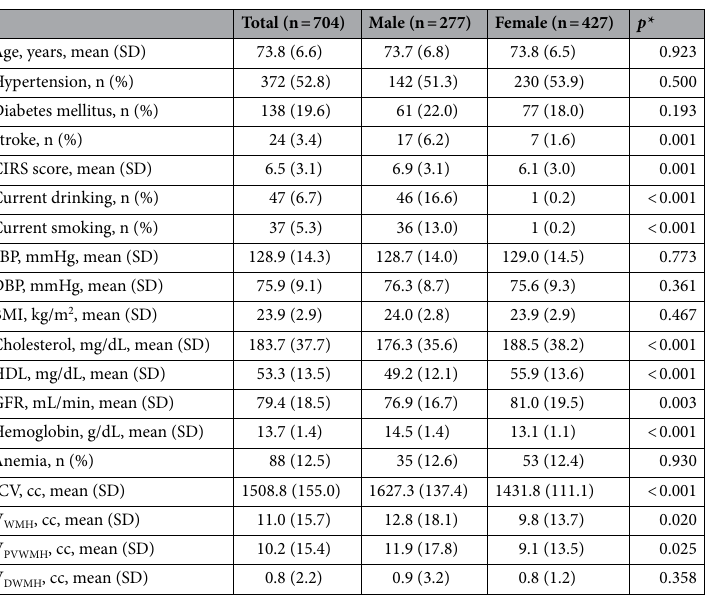
Table 1. Characteristics of participants. CIRS cumulative illness rating scale, SBP systolic blood pressure, DBP diastolic blood pressure, BMI body mass index, HDL high-density lipoprotein cholesterol, GFR glomerular filtration rate, ICV intracranial volume, V WMH volume of total white matter hyperintensity, V PVWMH volume of periventricular white matter hyperintensity, V DWMH volume of deep white matter hyperintensity. *Sex- differences by Student t-tests for continuous variables and chi-square tests for categorical